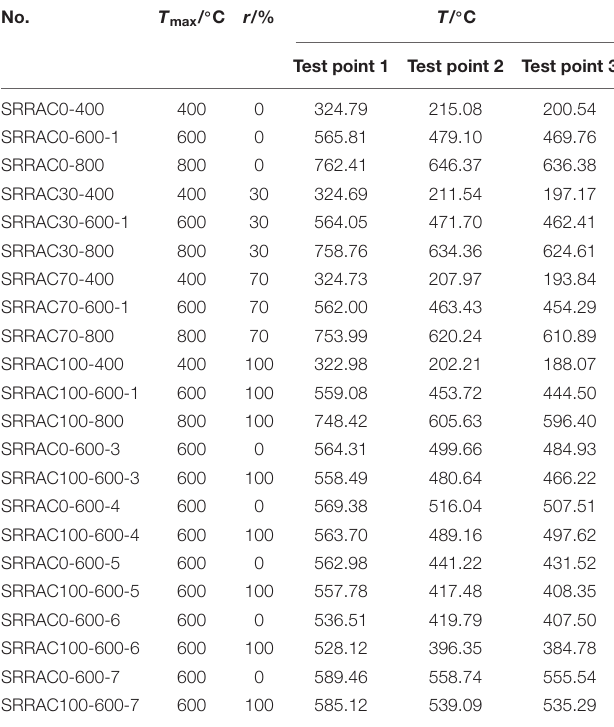
TABLE 6 | The highest temperature of different measure